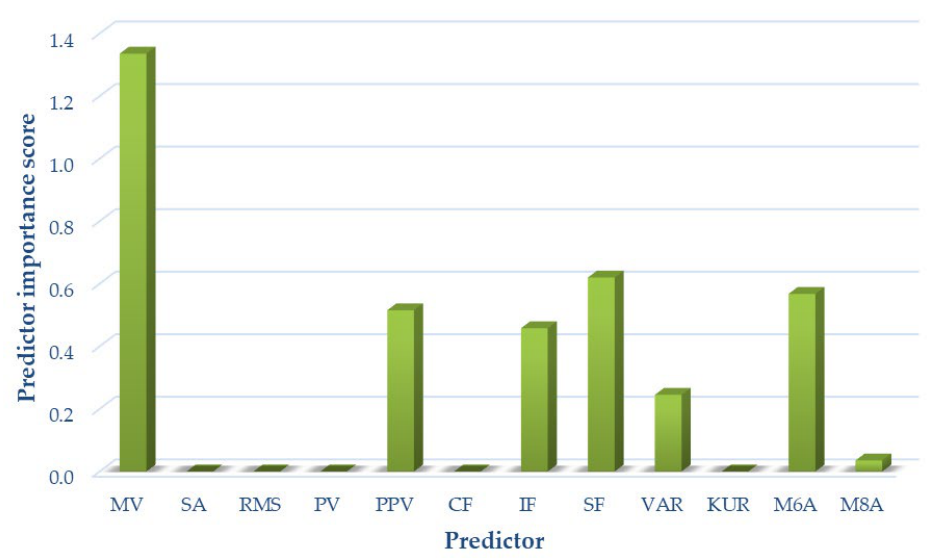
Figure 10. Selection of optimal features for variant III (OKC and CKC).